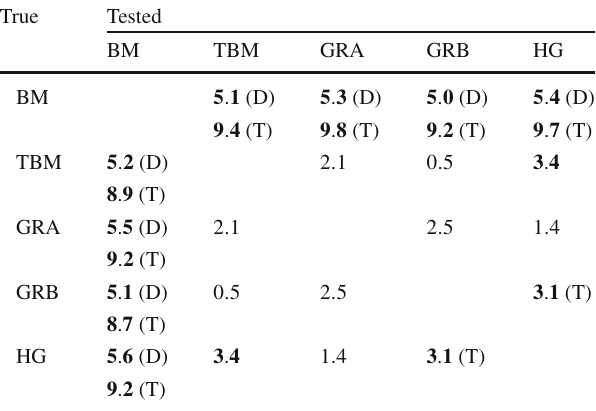
Table 7 Confidence levels (in number of σ ) at which the symmetry forms under consideration can be distinguished from each other by dif- ferent experiments in the case of possibility to have viable BM mixing in the neutrino sector. “D” and “T” stand for DUNE and T2HK, respec- tively. When not explicitly specified, the results are for DUNE + T2HK. Both in data and in test, sin 2 θ 12 has been set to 0 . 3343, while sin 2 θ 23 and sin 2 θ 13 have been fixed to their NO best fit